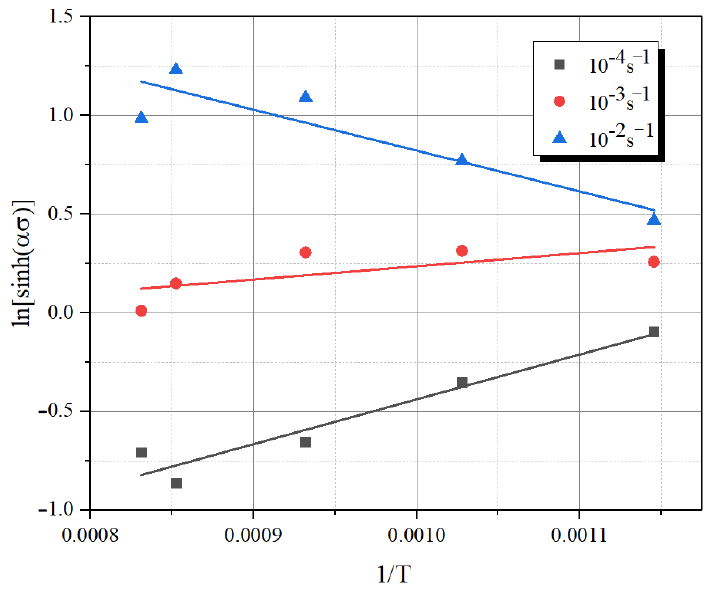
Figure 4. The fitting results of ln[sinh( ασ )]and 1/T.